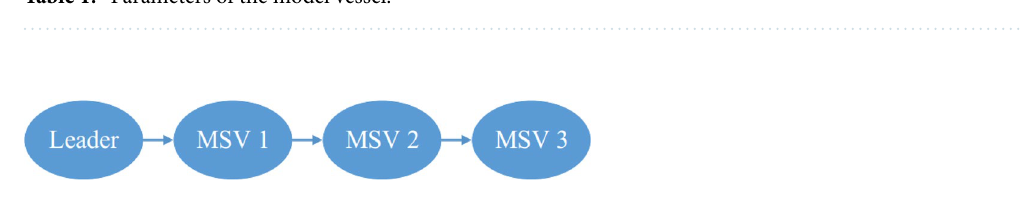
Table 1. Parameters of the model vessel.